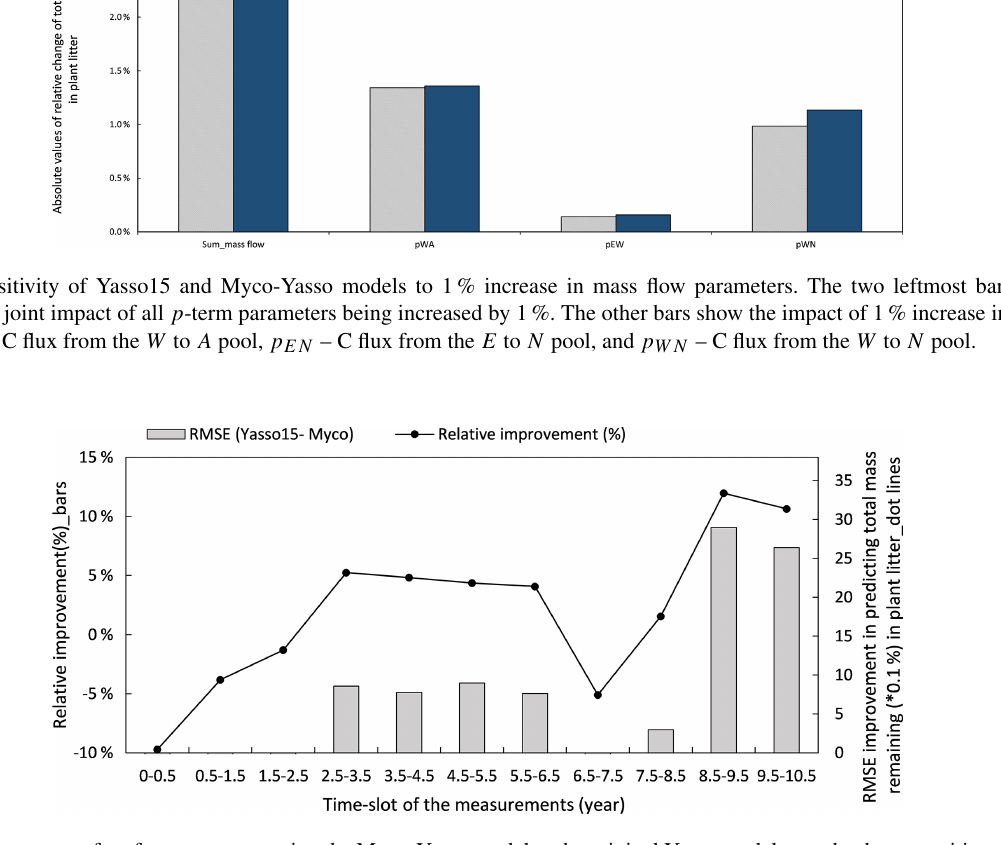
Figure C5. Improvement of performance comparing the Myco-Yasso model to the original Yasso model over the decomposition period. Bars represent the relative RMSE differences between Yasso15 and Myco-Yasso per period. The line with dots shows the absolute value of the RMSE differences (Yasso15 –